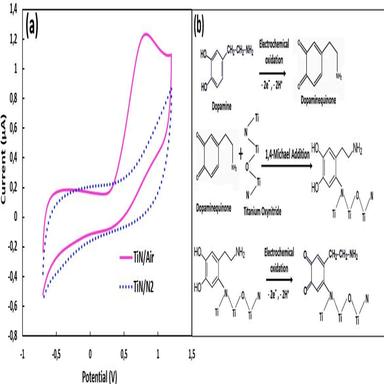
(a) CVs of TiN/N2 and TiN/Air electrodes in PBS solution (50 mM, pH = 7.4) containing 100 µM DA at scan rate of 50 mV/s. (b) supposable scheme of DA electrooxidation mechanism at TiN/Air electrode surface.